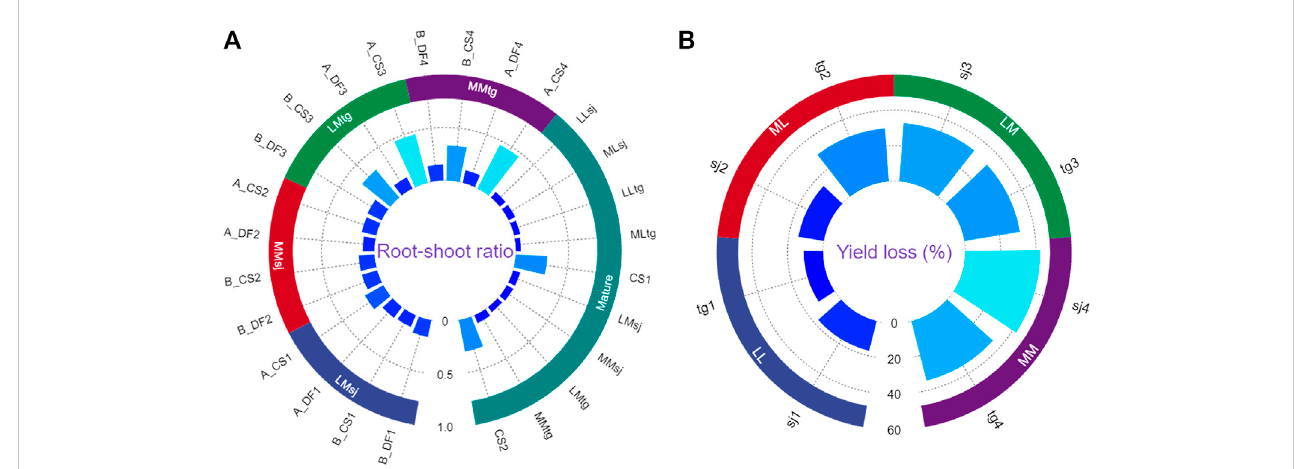
FIGURE 3 Root-shootratioindifferenttreatment (A) ;grainyieldlossofsummermaize (B) .Note:LLsj,MLsj,LLtg,MLtg,CS1,LMsj,MMsj,LMtg,MMtg,andCS2,same to theaboveexplanations. B_DF,after droughtperiodofdrought- fl oodabrupt alternation (DFAA);A_DF, after fl ooding periodofDFAA;B_CS,A_CS, changes in CS treatment at the same time point of B_DF,